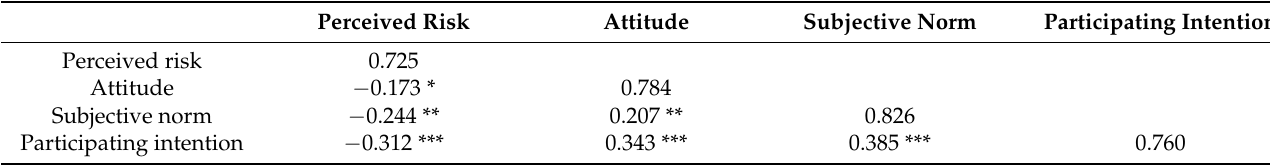
Table 5. The results of discriminant validity.